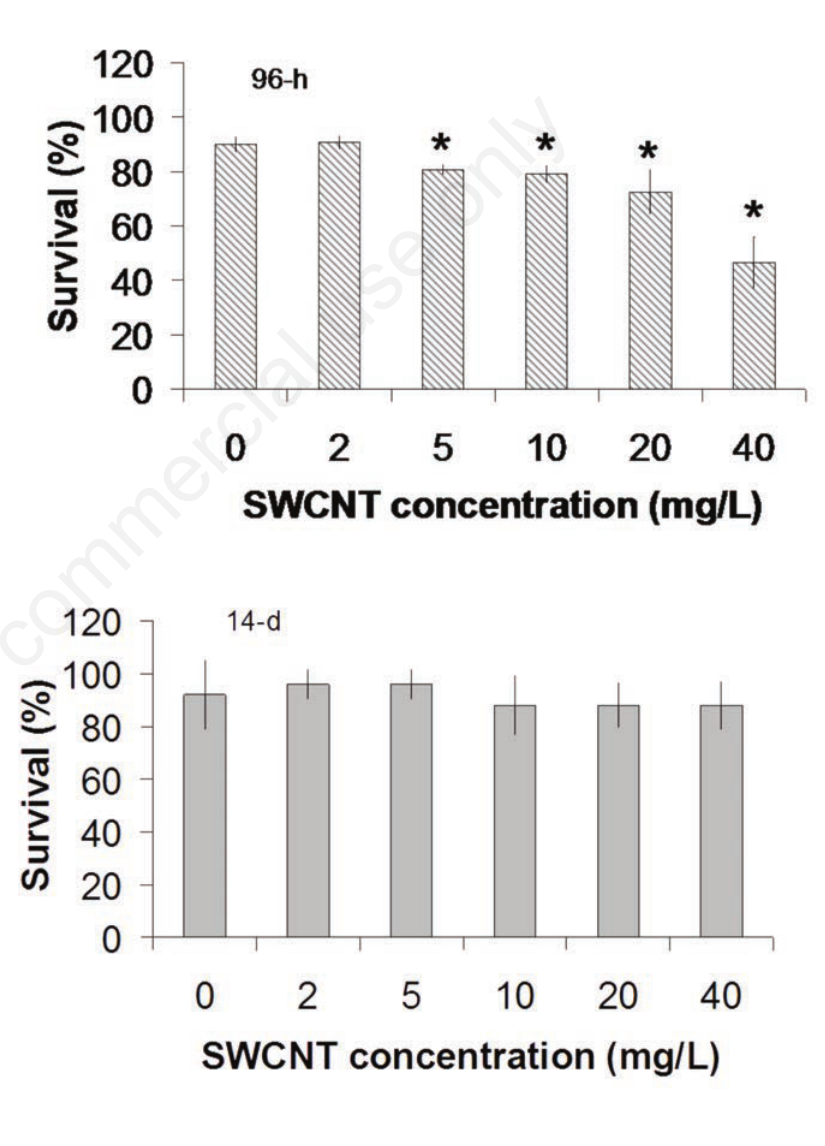
Figure 5. Mean survival of Hyalella azteca exposed to different concentrations of single- walled carbon nanotubes (SWCNT) in M4 for 96 h in water-only, where each column is the mean of 3 experiments (4 replicates per experiment) ± standard error, and 14 days in the presence of sediment, where each block is the mean of 6 replicates ± standard devia- tion. * Indicates significant difference of group exposed compared to the negative